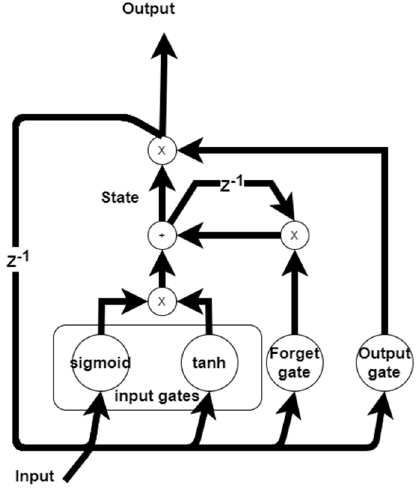
Figure 4. LSTM internal structure.